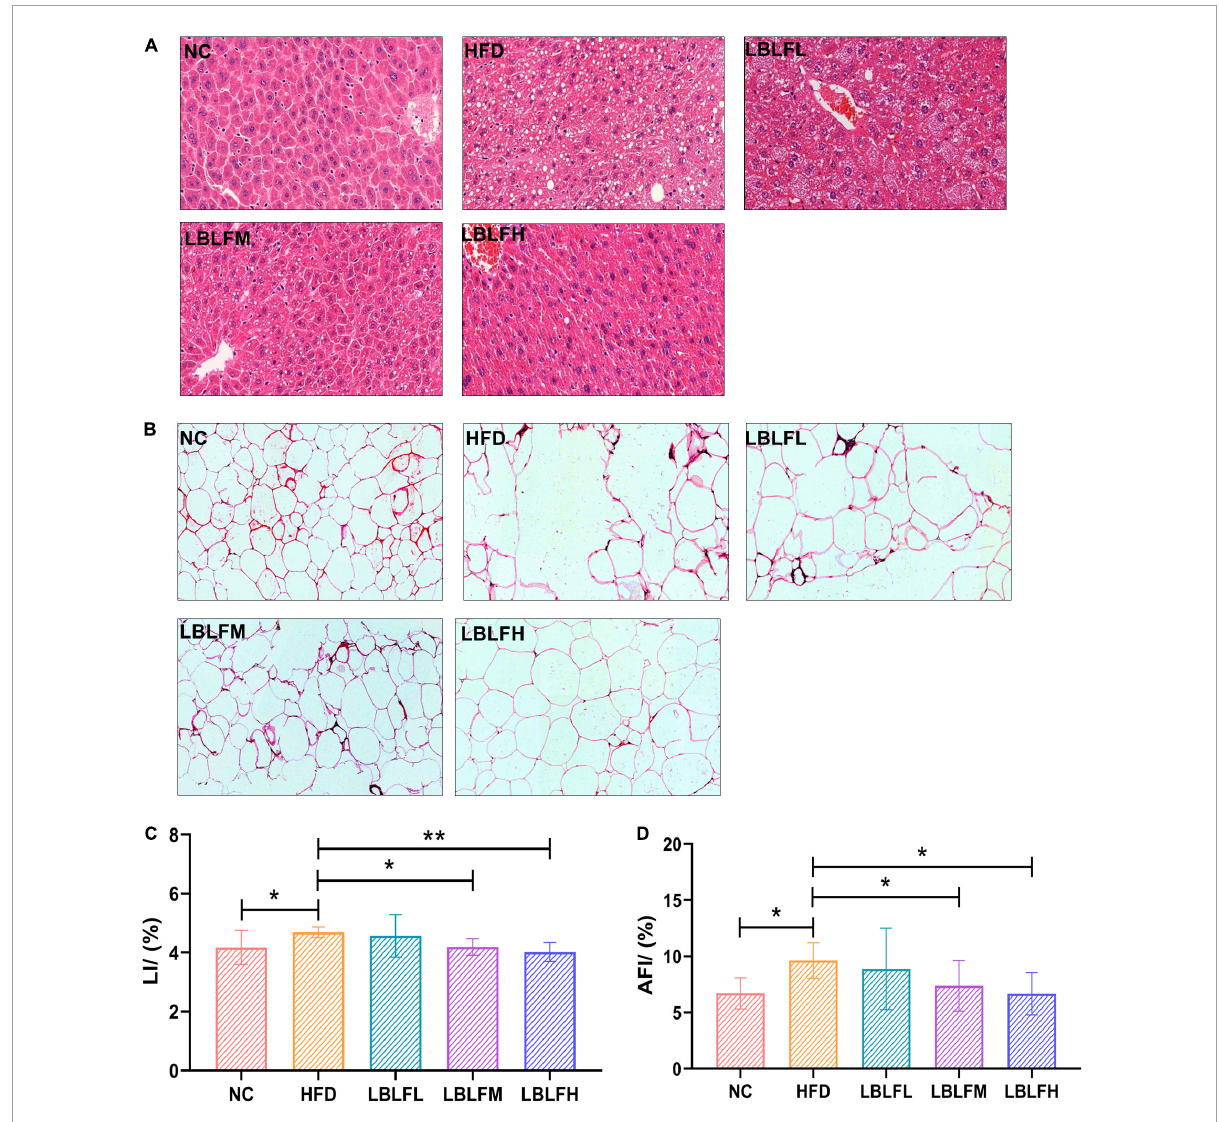
FIGURE5 Effects of LBLF supplement on photographs of HE-stained sections of tissues and their related indexes in obese mice. (A) HE-stained sections of liver ( × 200); (B) HE-stained sections of abdominal fat tissues ( × 200); (C) LI (liver index); (D) AFI (abdominal fat index). (* p < 0.05) and (** p < 0.01) vs. HFD